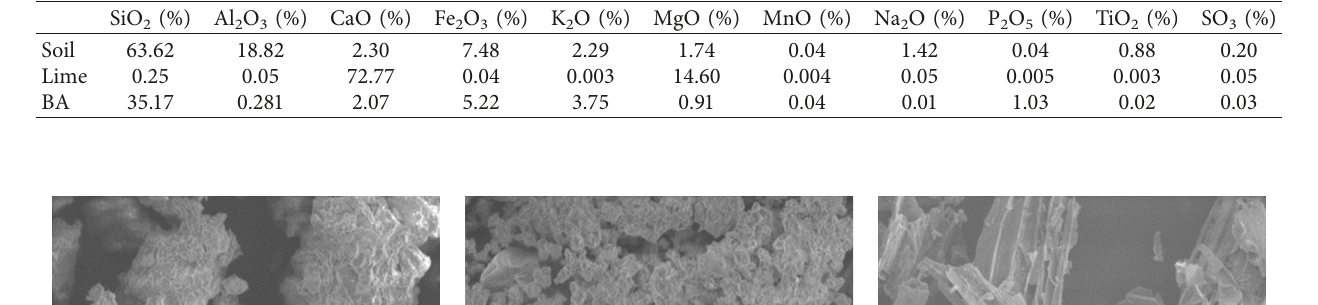
Table 2: Chemical composition of